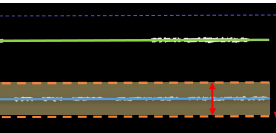
Figure 13. The process of buffer-analysis-based lane line inference. The purple continuous line is the trajectory, while the green line is the right host lane line. The green line is moved parallel to the right, and white pixels are searched for in a buffer that ranges from W − 0.5 m to W + 0.5 m, as indicated by the orange area. The blue line that matches the white pixels best is selected as the candidate lane